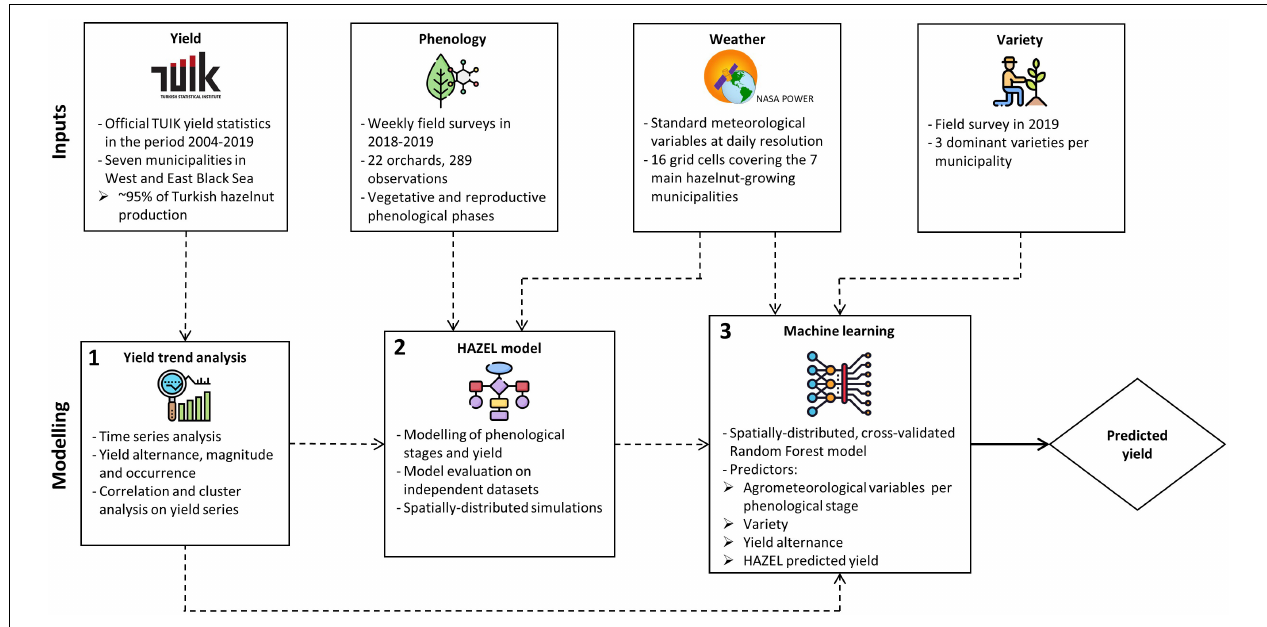
FIGURE 1 | The HADES yield prediction system. Input data sources (official yields, phenological observations, weather data, and main varieties per municipality) are used in a three-step workflow: a statistical analysis of the yield series, the application of the process-based HAZEL model, and the use of a machine learning layer to optimize the system